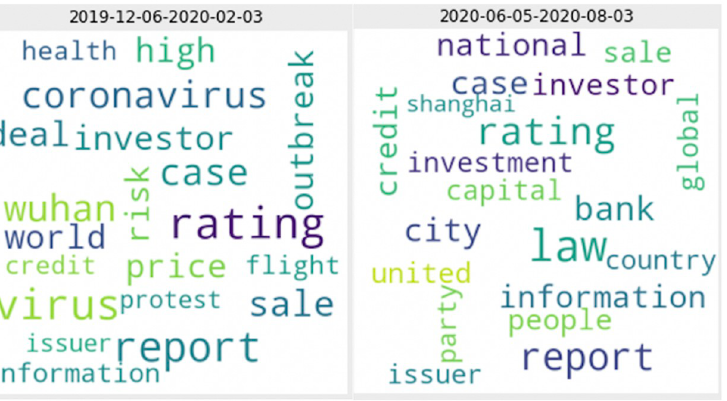
Fig 16. Word cloud from 2019-12-06 to 2020-02-03 and 2020-06-05 to 2020-08-03. These word clouds show the words from 2019-12-06 to 2020-02-03 and 2020-06-05 to 2020-08-03 in which their topic distributions and word distributions are used to constructed different topic score measures for the predictions on 2020-02-04 and 2020-08-04, respectively.